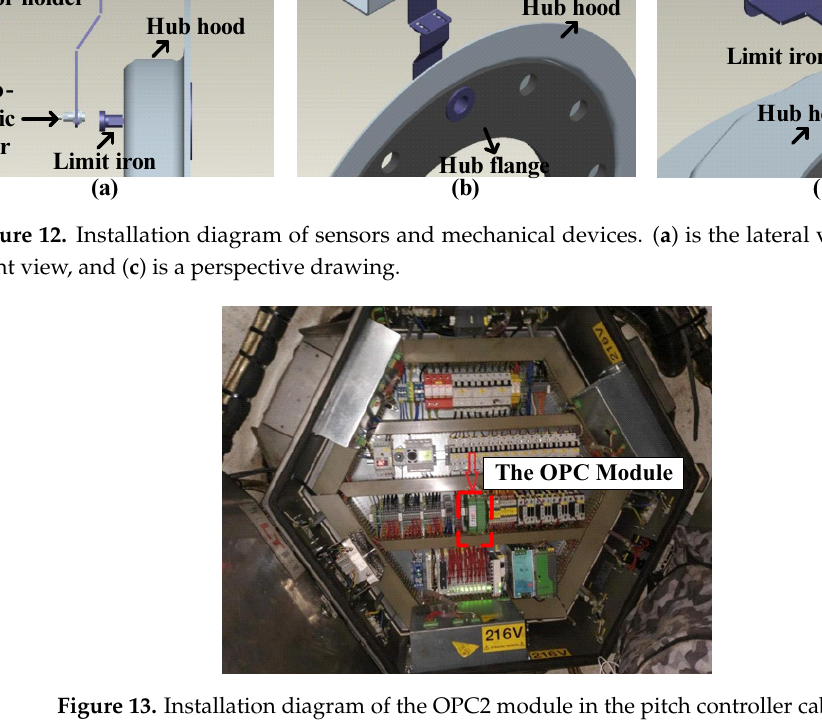
Figure 13. Installation diagram of the OPC2 module in the pitch controller